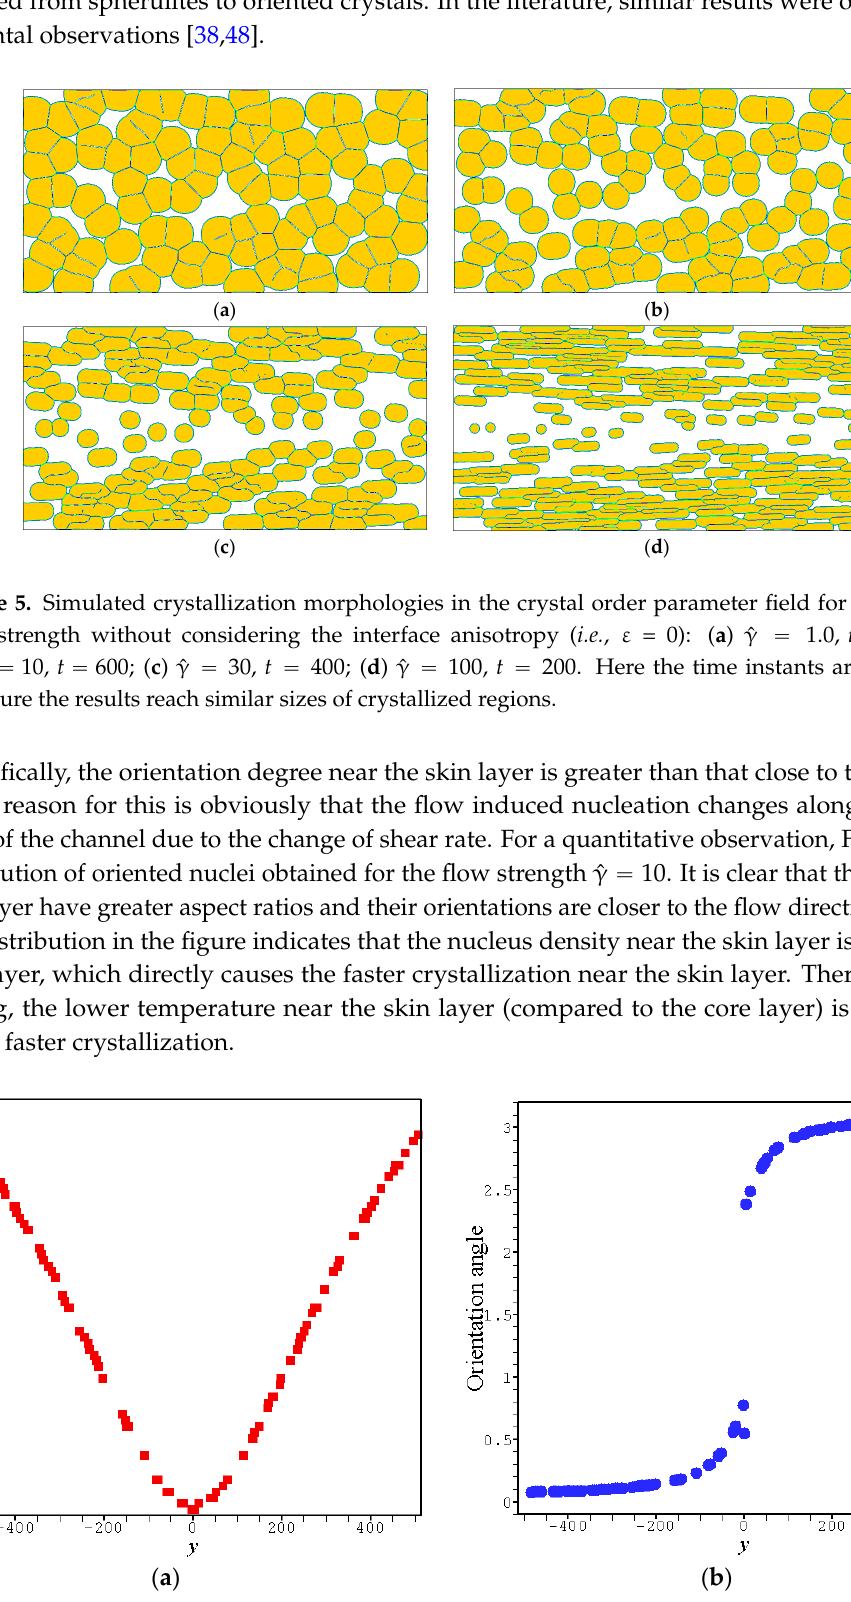
Figure 6. Distribution of the oriented nuclei along the y -axis obtained for ˆ γ “ 10, where each symbol represents a nucleus: ( a ) aspect ratio; ( b ) orientation angle.